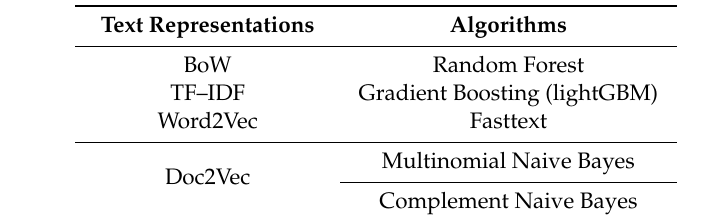
Table 3. Text representations and algorithms used.